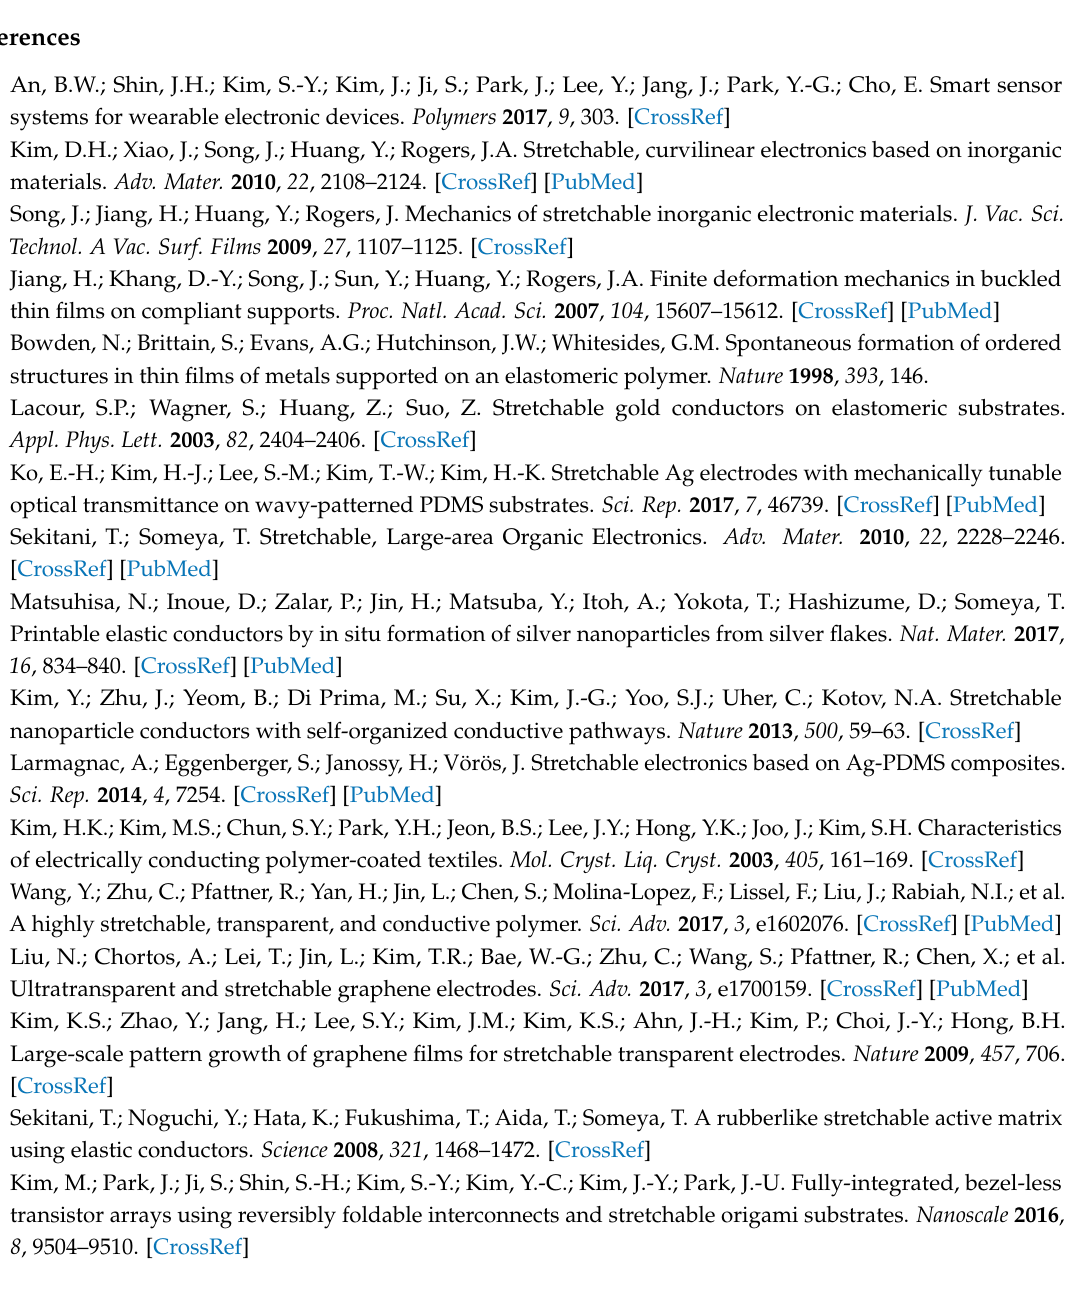
Supplementary Materials: Figure S1: Inkjet-printed silver patterns on untreated silicone ( a–c ) and plasma-treated silicone ( d–f ). ( a , d ): printed areas larger than the image area, ( b , e ): printed vertical lines, ( c , f ): printed horizontal lines. The satellite drops in picture b and e result from inaccuracies of the cheap desktop inkjet printer [23]. Video S1: Implementation on a wearable, Video